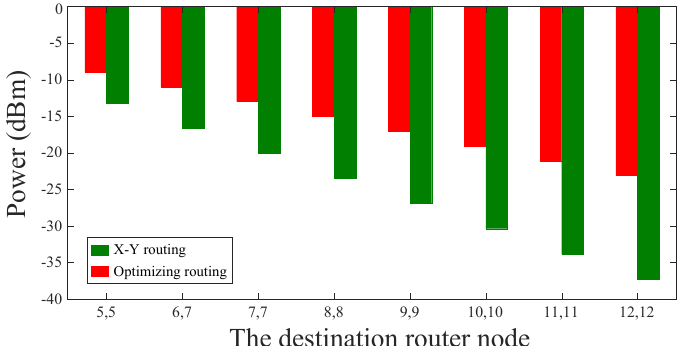
Figure 11. Signal power comparison of the longest optical links in different optical network sizes.